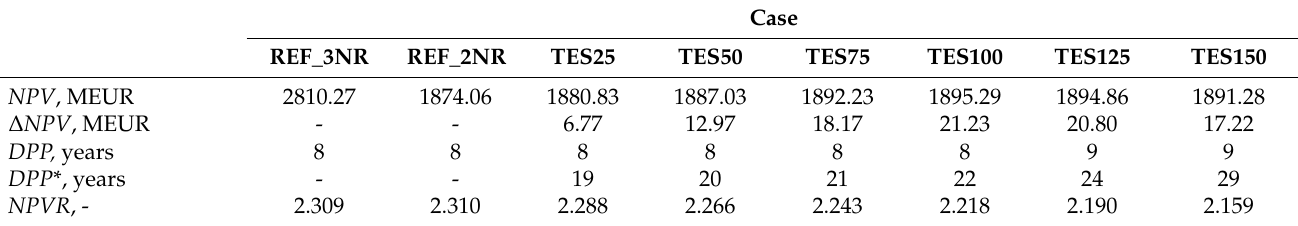
Table 4. Results of economic analyses for nominal